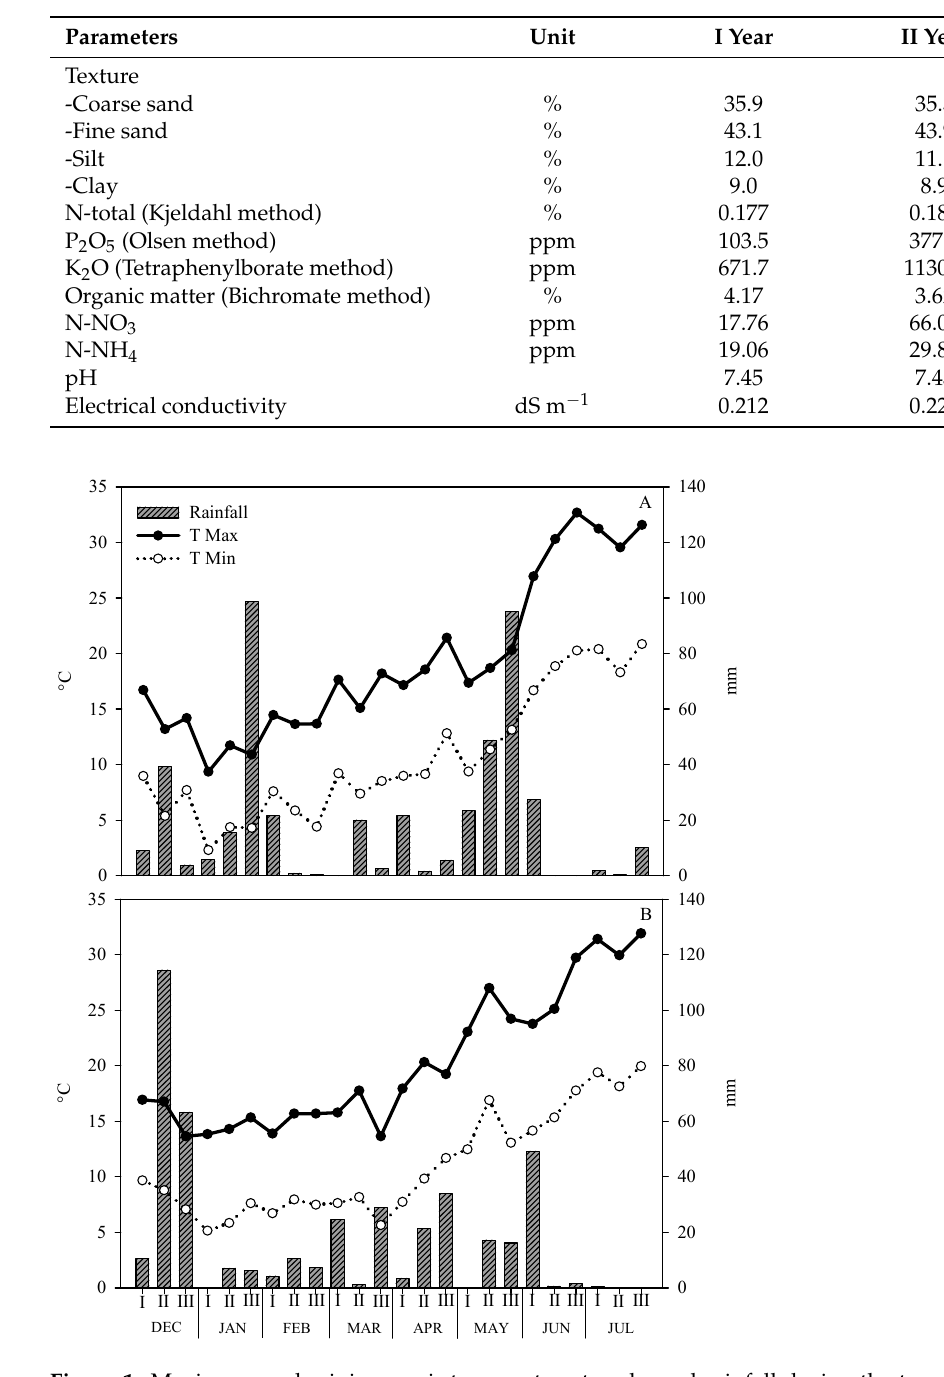
Table 1. Physical and chemical properties of the soil in both years.